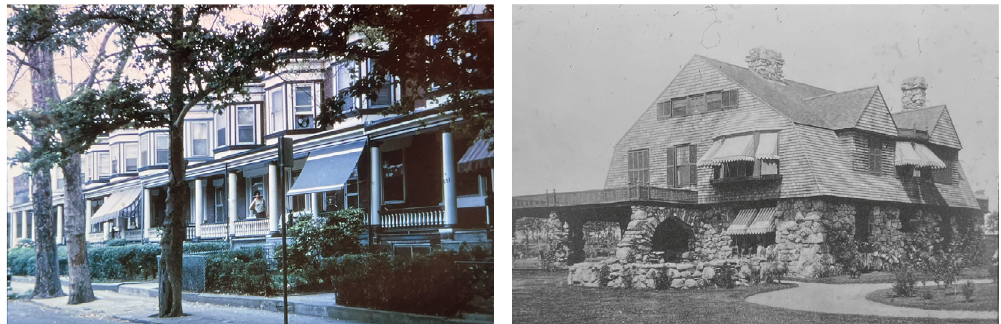
Fig. 3 Robert Venturi, Scott Brown Collection. Color slides made by Robert Venturi